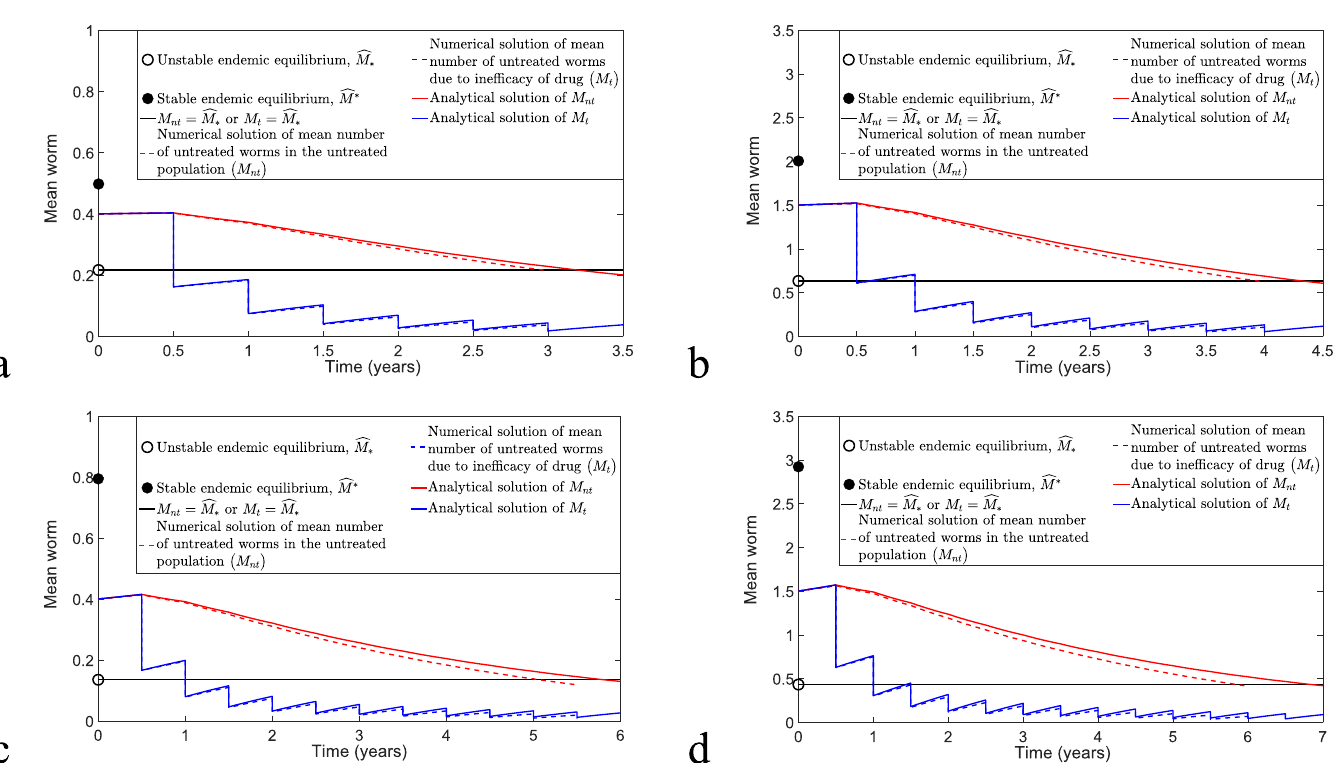
Fig 8. Numerical comparison of model (12) and (13) and model (9) and (10) by considering the implementation of biannual MDA with � = ω = 0.6 and varying k and R 0 values. (a) k = 0.05, R 0 = 1.8 and MSE for M nt and M t are 5.9377 × 10 − 5 and 1.1881 × 10 − 5 , respectively. (b) k = 0.2, R 0 = 1.8 and MSE for M nt and M t are 1.5909 × 10 − 3 and 2.2534 × 10 − 4 , respectively. (c) k = 0.05, R 0 = 2 and MSE for M for M nt and M t are 4.5018 × 10 − 3 and 4.7219 × 10 − 4 ,